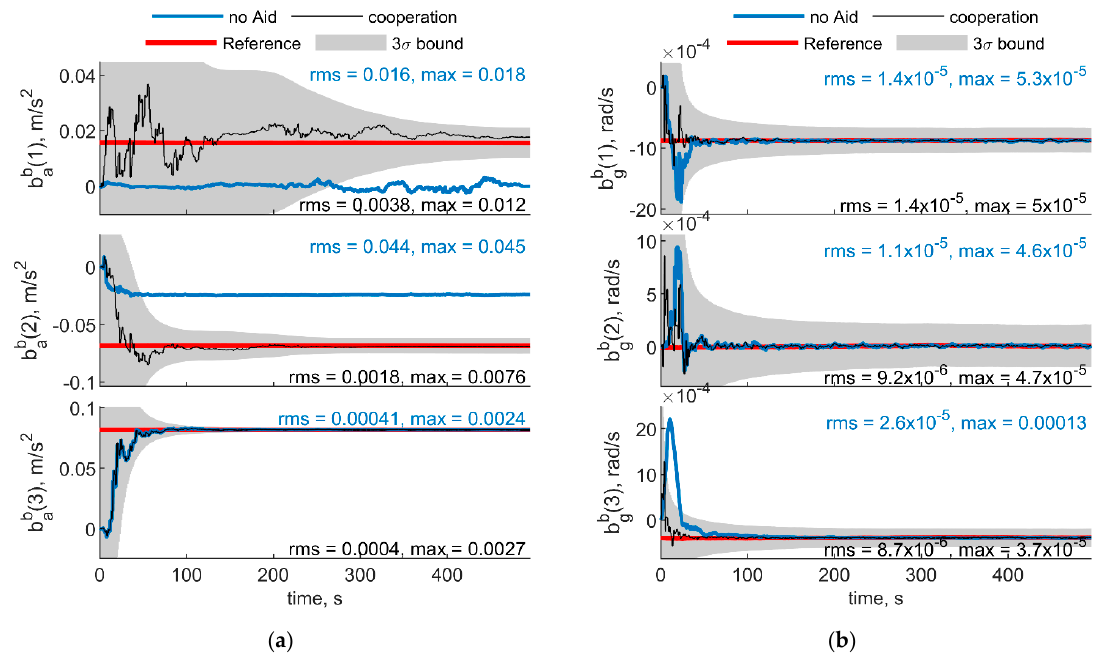
Figure 16. ( a ) Accelerometer and ( b ) gyroscope biases predicted by the filter. One deputy. Chief and deputy move along UAV 2 and UAV 1 trajectories reported in Figure 13, respectively, as reported in case 1. Reference value is reported in red. Results obtained with cooperation and without cooperation have been reported in black and blue, respectively. RMS and maximum error value have been evaluated starting from t = 60 s.